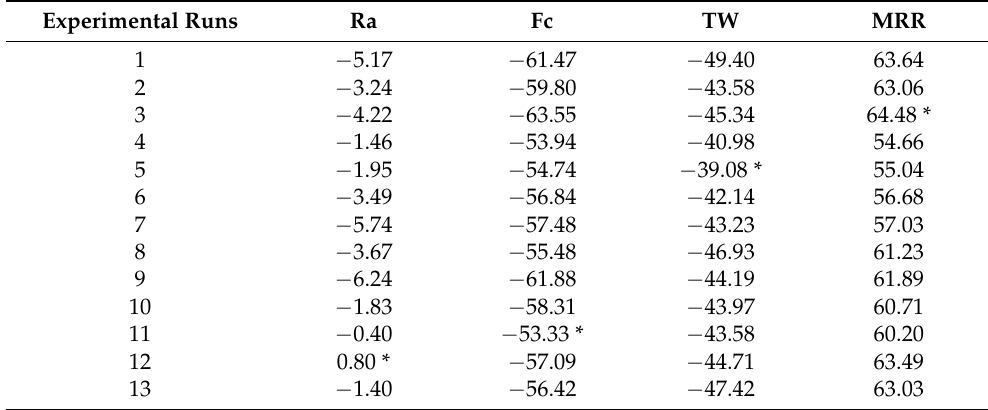
Table 8. S/N ratios of individual